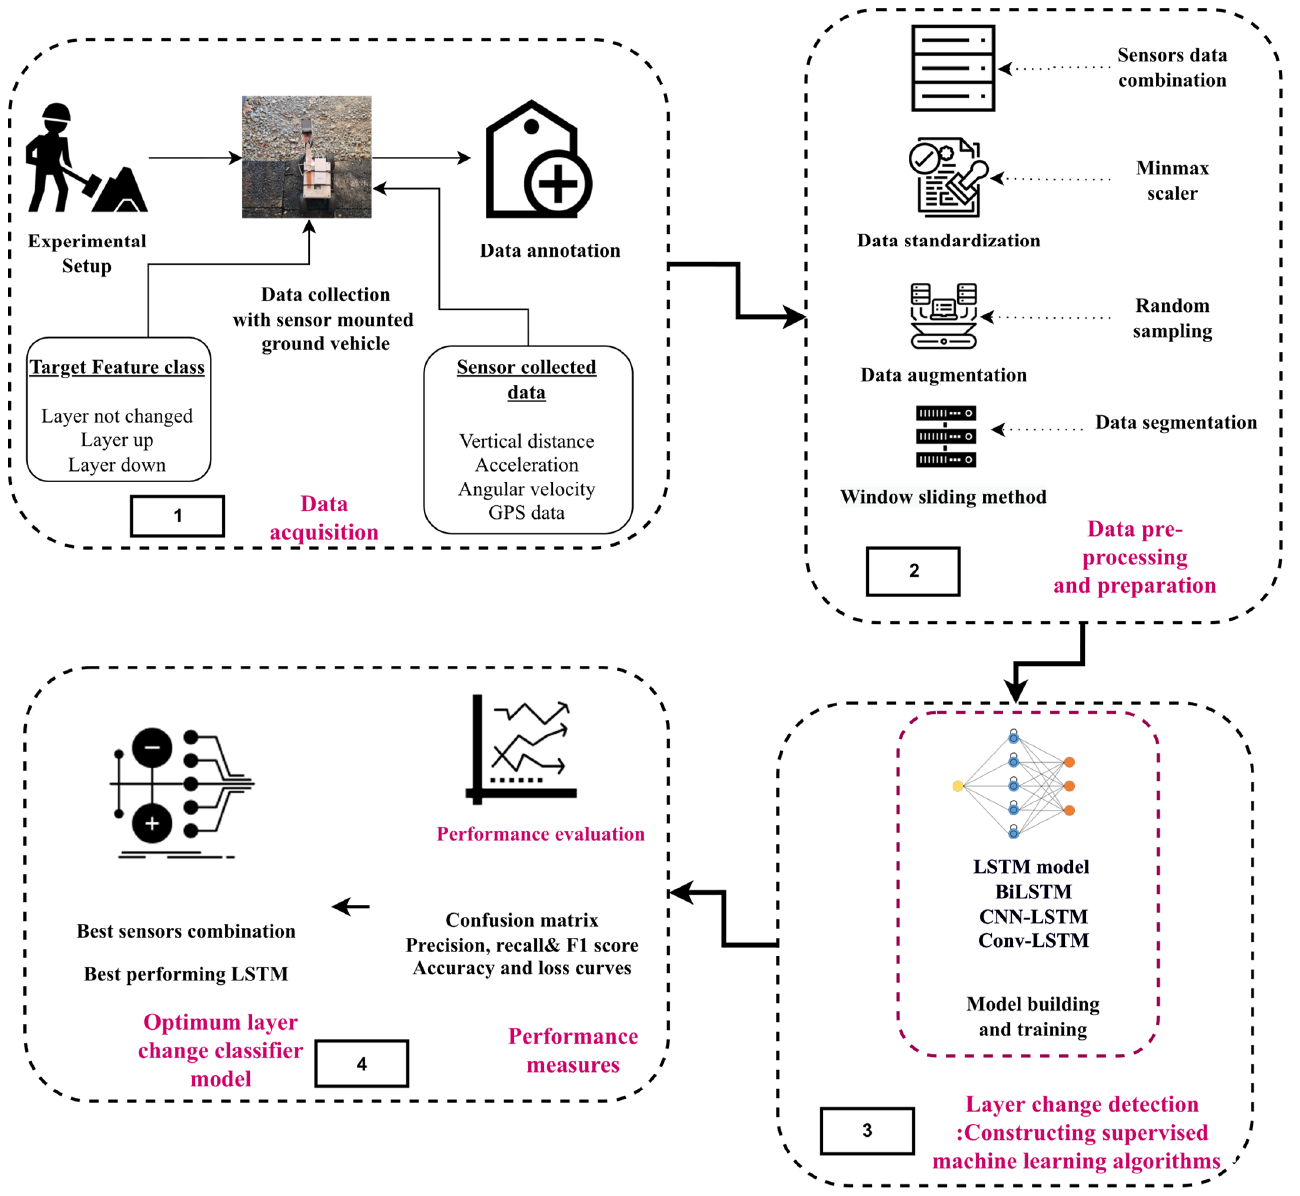
Figure 2. Overall framework of research methodology of sensors mounted on a UGV to detect road layer change using a deep learning